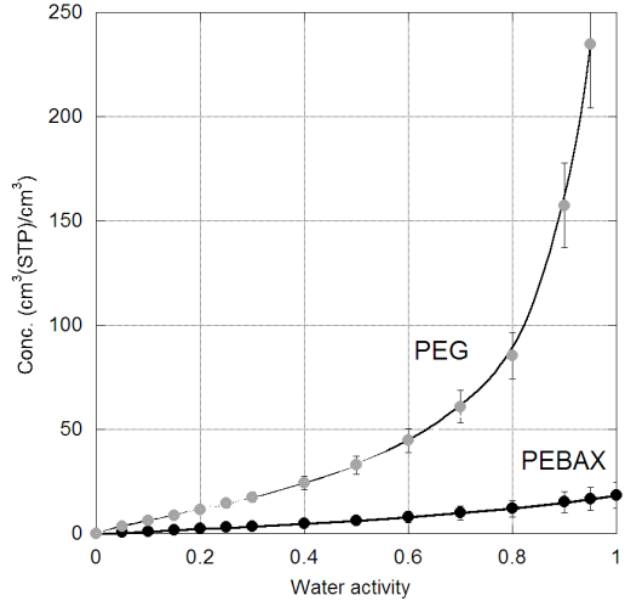
Figure 3. H 2 O sorption isotherm in PEBAX (black) and PEG (grey) at 35 °C.